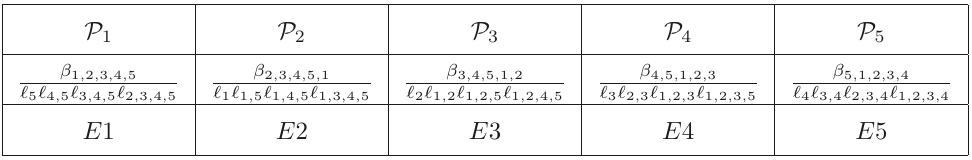
Table 1 . Final results for the pentagon diagrams. The first line lists the terms while the second line their analytic expressions respectively. The last line shows the forward-limit channels corresponding to each term, where the cut lines in the Q-cut analysis are depicted in figure 9. For a given cut line, its momentum is chosen to be ℓ